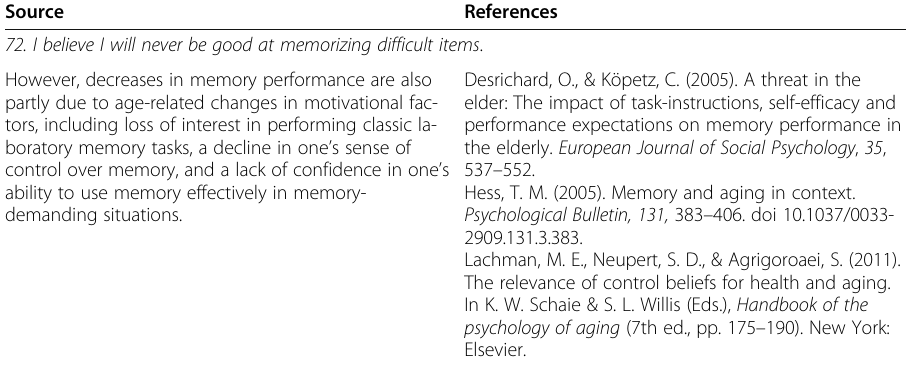
Table 5 Memory self-efficacy; exemplar item with the source and references